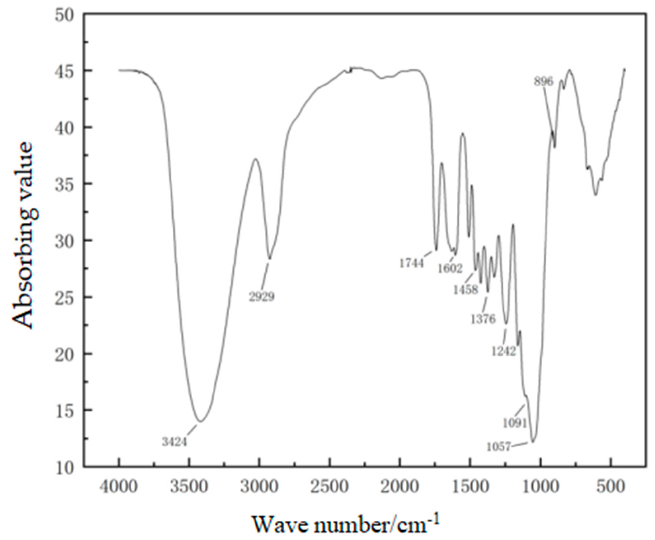
Figure 4. FTIR spectrum of a hemp stalk.